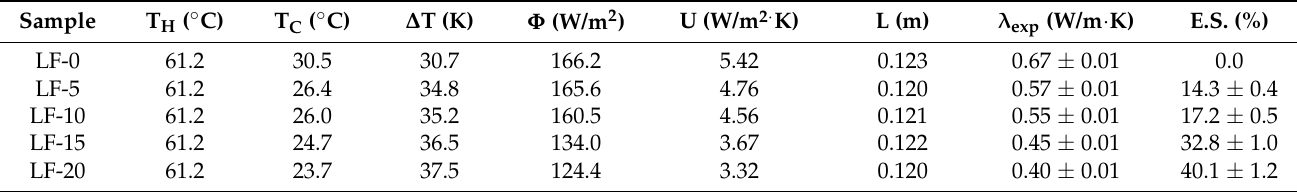
Table 4. Experimental thermal conductivity and energy saving of the samples of lime mortar with different iron (III) oxide content.